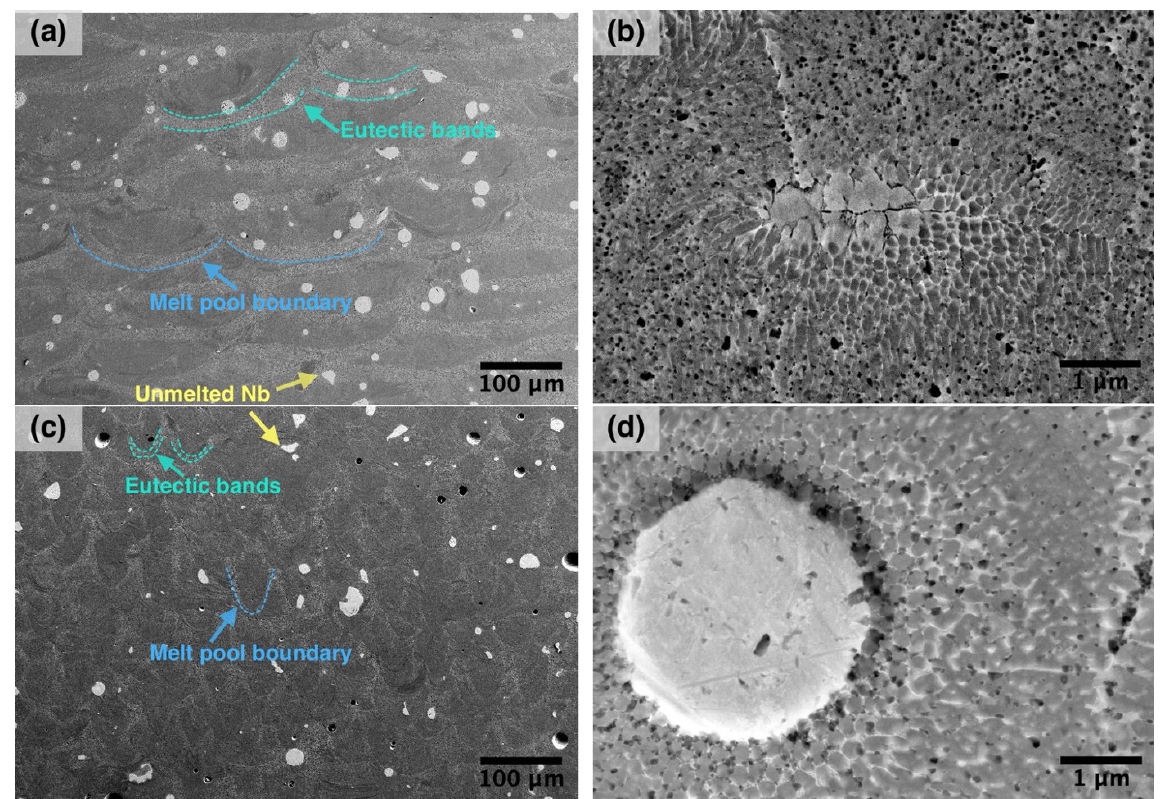
Figure 4. SEM-images showing the microstructure of the NiTiNb samples produced using parameter sets ( a , b ) E1 and ( c , d ) A1.